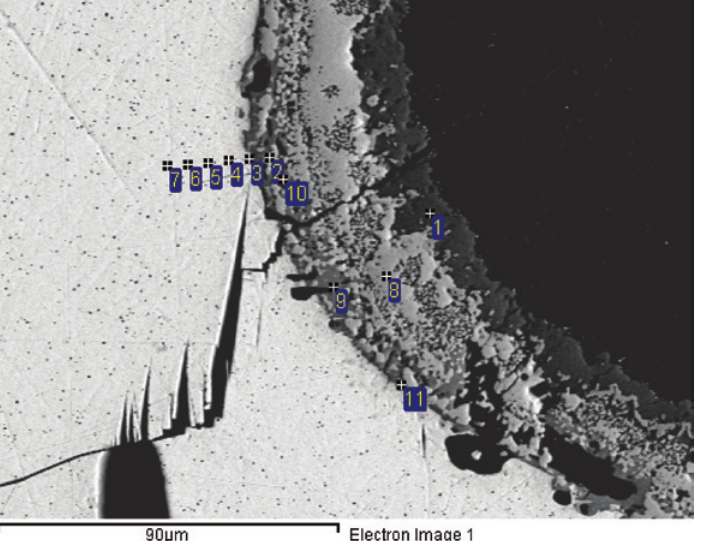
Fig. 4: Oxidation scales formed on Cu 2 Se at 550 °C in an O 2 –20% SO 2 atmosphere: black outer layer of CuSO 4 (point 1) on Cu 2 O (point 2, 8) and a Cu-Se-oxide (points 9–11); CuO is also visible in the fine grained surface scale and points (3–7) give the analysis of non-reacted Cu 2 Se with about 60% phases containing oxygen. The outer surfaces of copper Significant porosity is also formed on the Cu Se-Cu O-CuO 2 2 oxides are generating copper sulfate layer densely on CuO. interface. flowing O -20 vol% SO atmosphere at 550 °C are shown in 2 2 Figure 4. The reaction products are essentially separated by a large porosity from the primary Cu Se, in a similar 2 way as in the case of Ag Se [15]. The EDS analyses indicate 2 that the scale also contains traces of selenium-bearing